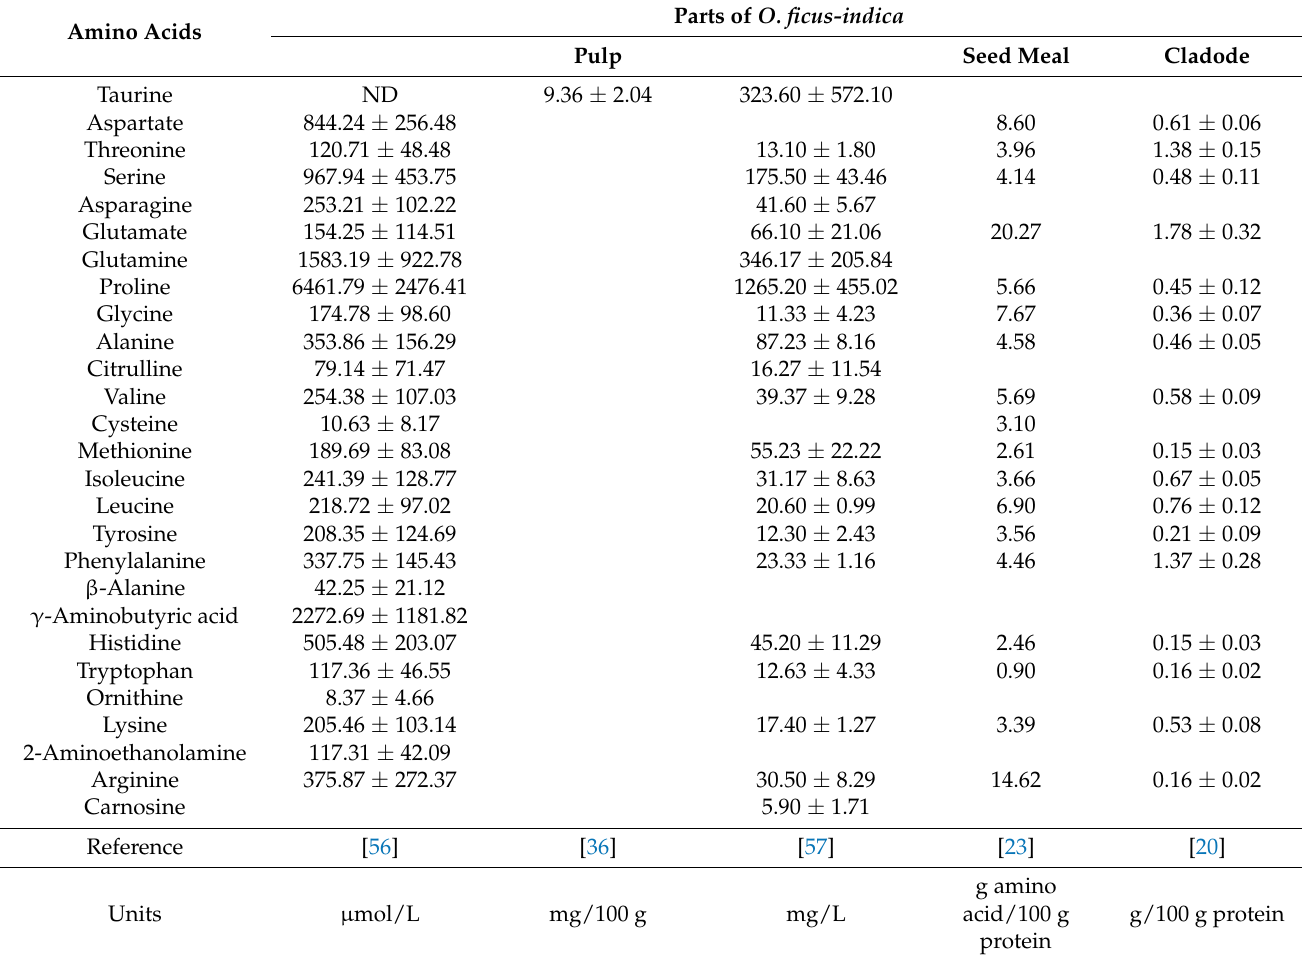
Table 6. Amino acid content of the different parts of Opuntia ficus-indica (L.) Mill. Amino